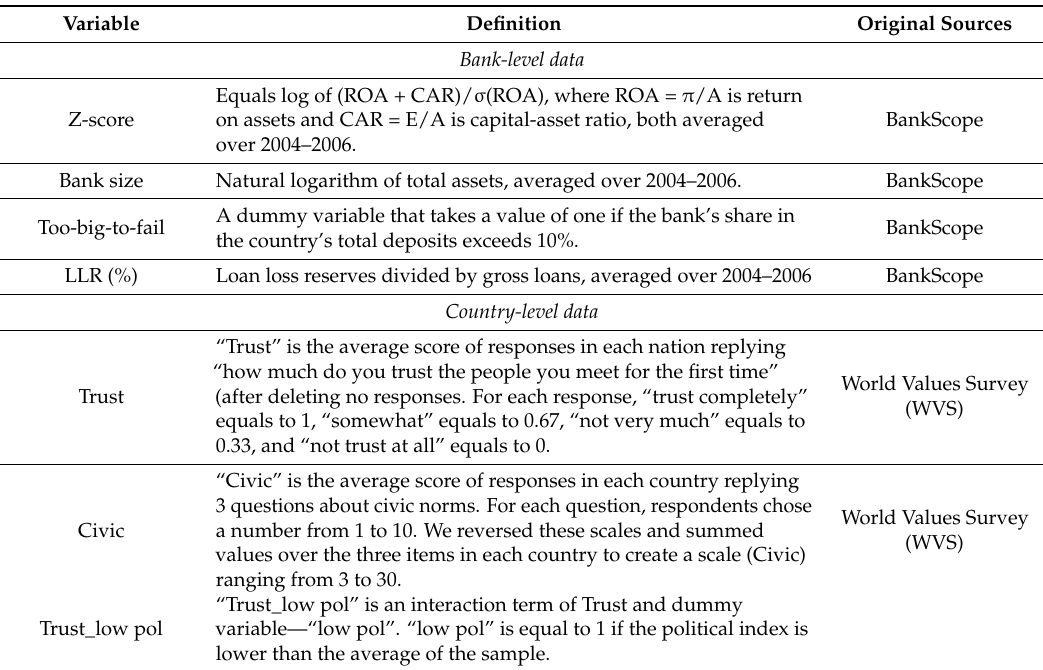
Table A1. Definitions of